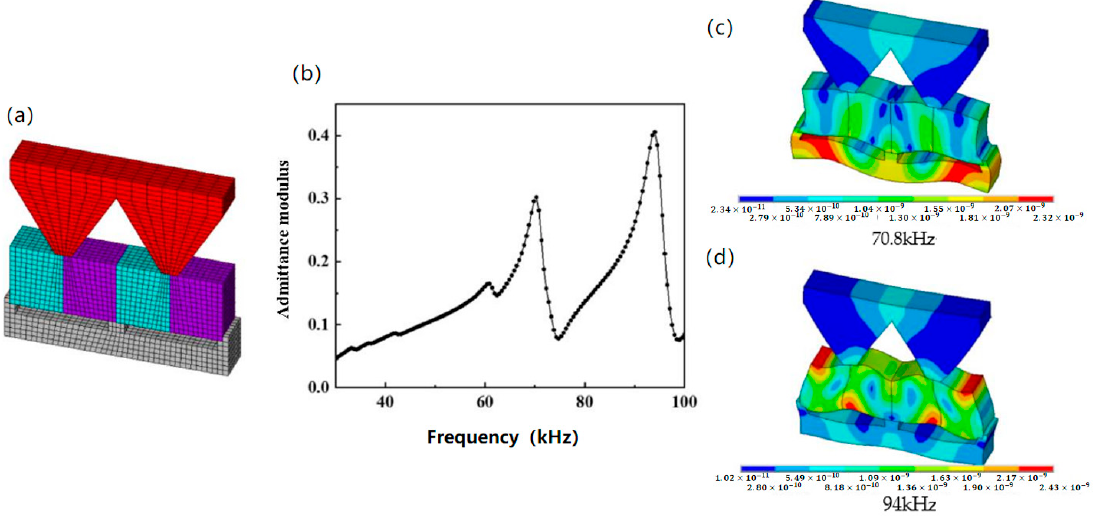
Figure 5. Finite element simulation results of piezoelectric oscillator. ( a ) Mesh model; ( b ) admittance modulus curve; ( c ) vibration mode@70.8kHz; (d) vibration mode@94kHz.